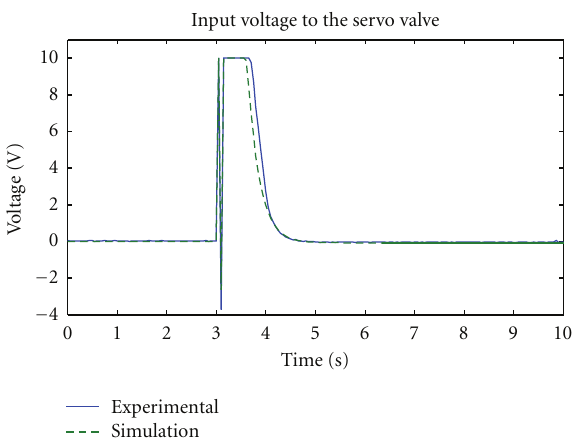
Figure 10: Input signal from the controller in simulation and experimental.